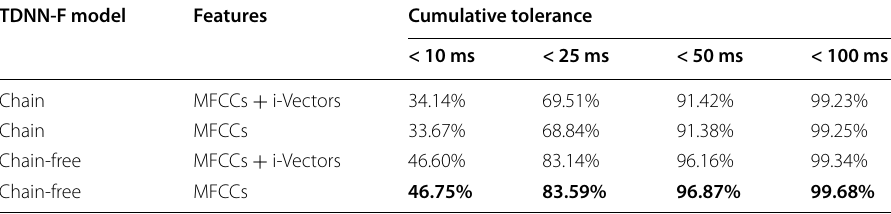
Table 14 Phone boundary results for the male